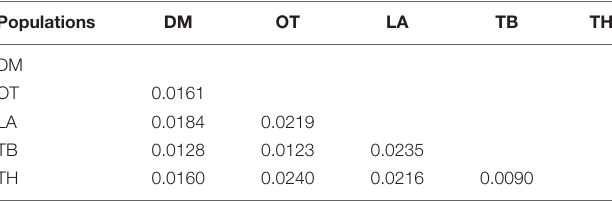
TABLE 5 | Pairwise F ST estimates between the five chicken populations based on the 20 microsatellite loci. Populations DM